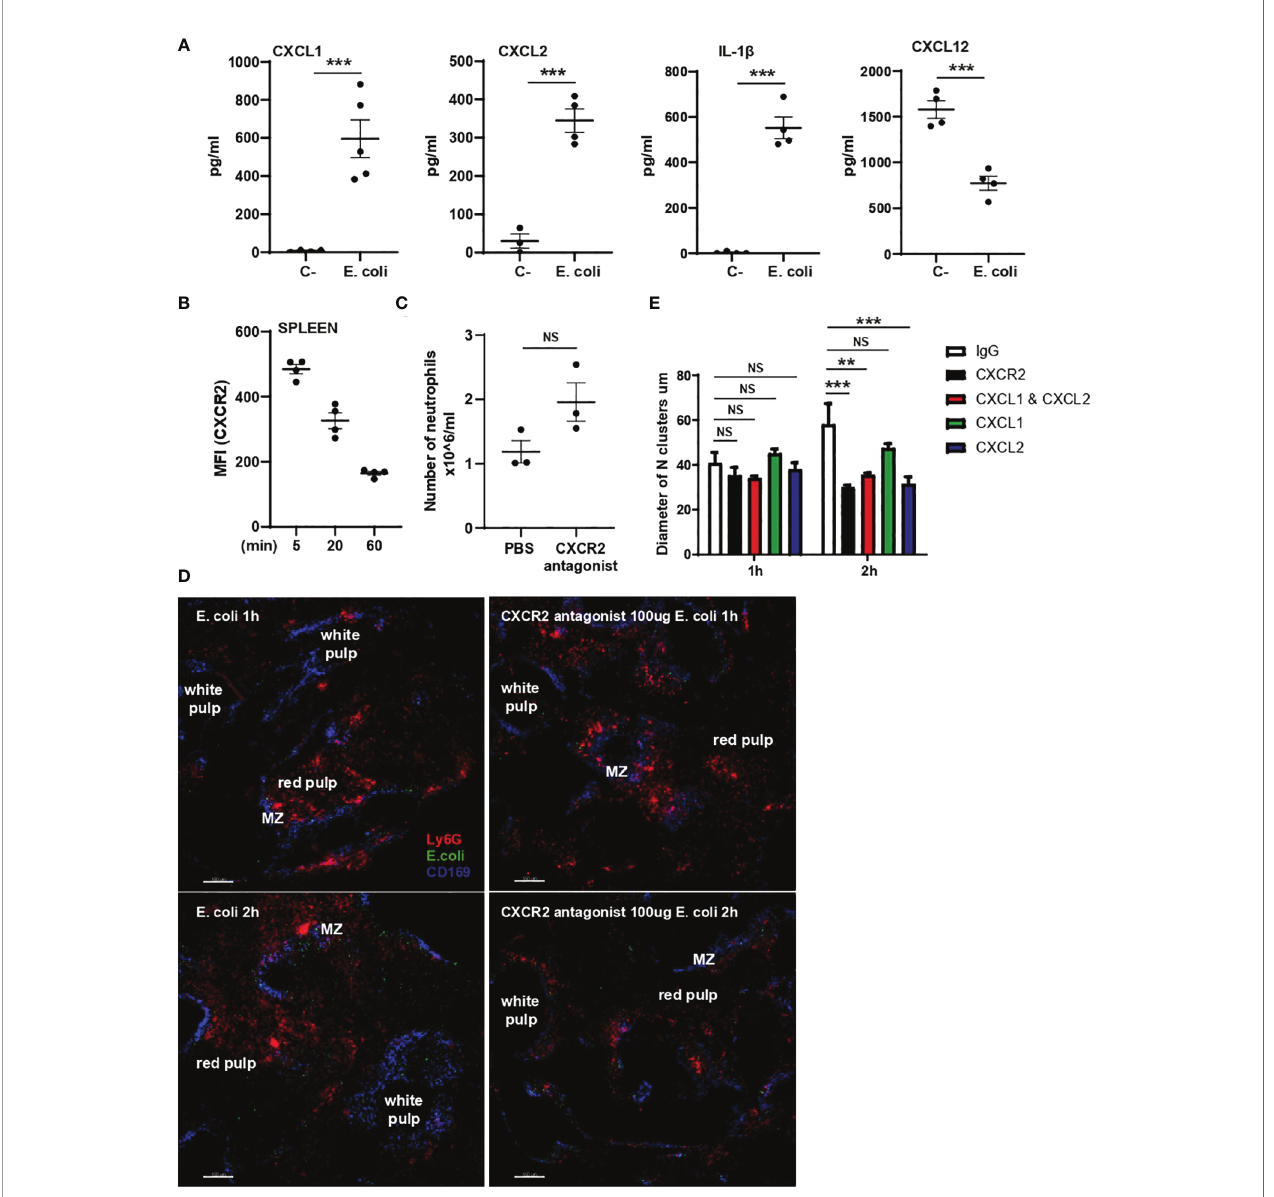
FIGURE 6 | CXCL1, CXCL2, IL-1 b and CXCL12 expression in splenic supernatant and CXCR2 role in cluster enlargement. (A) CXCL1, CXCL2, IL-1 b and CXCL12 ELISAs of splenic supernatant of PBS (C-) or E. coli treated mice (N=4-5). (B) MFI (anti-CXCR2 fl uorophore) expression on splenic neutrophils 5, 20 and 60 min after i.v. injection of E. coli , (N=4 mice/treatment). (C) Total number of splenic neutrophils of mice treated for 60 min with PBS or CXCR2 antagonist, unpaired t-test (N=3 mice/treatment). (D) 3D ex-vivo culture system of living PCSS over time pre-treated with PBS or CXCR2 antagonist and challenged with systemic E. coli for 5min. Scale bar 150µm. (E) Quanti fi cation of the diameter of neutrophil clusters in 3D ex-vivo culture of living PCSS over time pre-treated with IgG, CXCR2 antagonist, CXCL1 mAb, CXCL2mAb, and CXCL1 and CXCL2 mAb over time, one-way ANOVA, Tukey ’ s multiple comparison test, two independent experiments, (N=3 time/ treatment). P < 0.01 **, P < 0.001 ***, NS, non signi fi